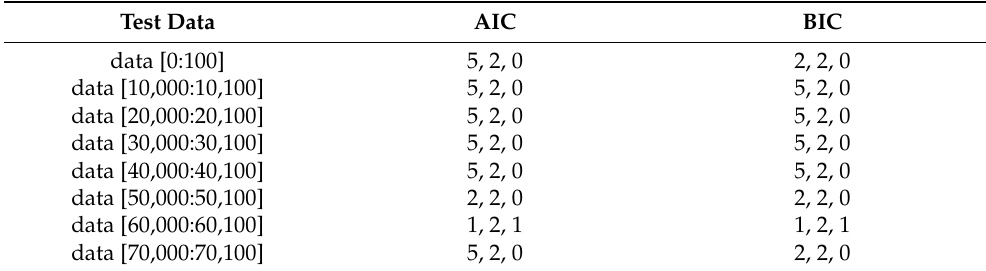
Table 4. Best (p, d, q) selection.